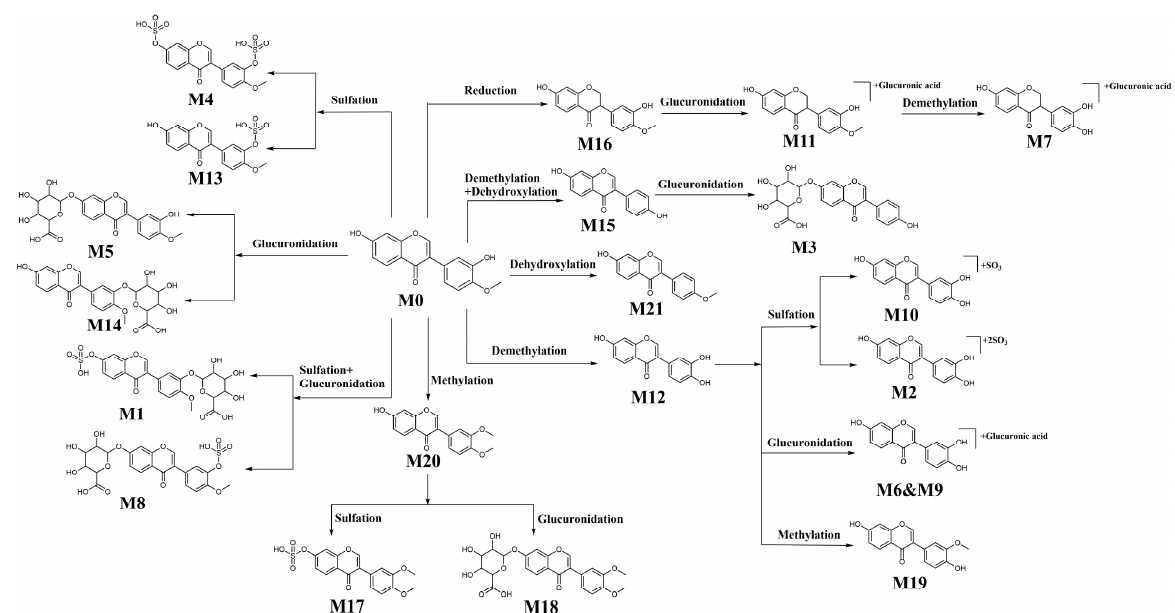
Figure 4. Proposed transformation pathways of orally administrated calycosin in rats. Table 1. Summary of the mass spectral data of calycosin and its metabolites detected in the biolog- ical samples of rats.